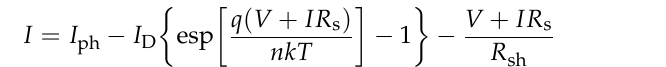
Figure 1. Hot spot effect of photovoltaic module: ( a ) photovoltaic module; ( b ) infrared image of the photovoltaic module.